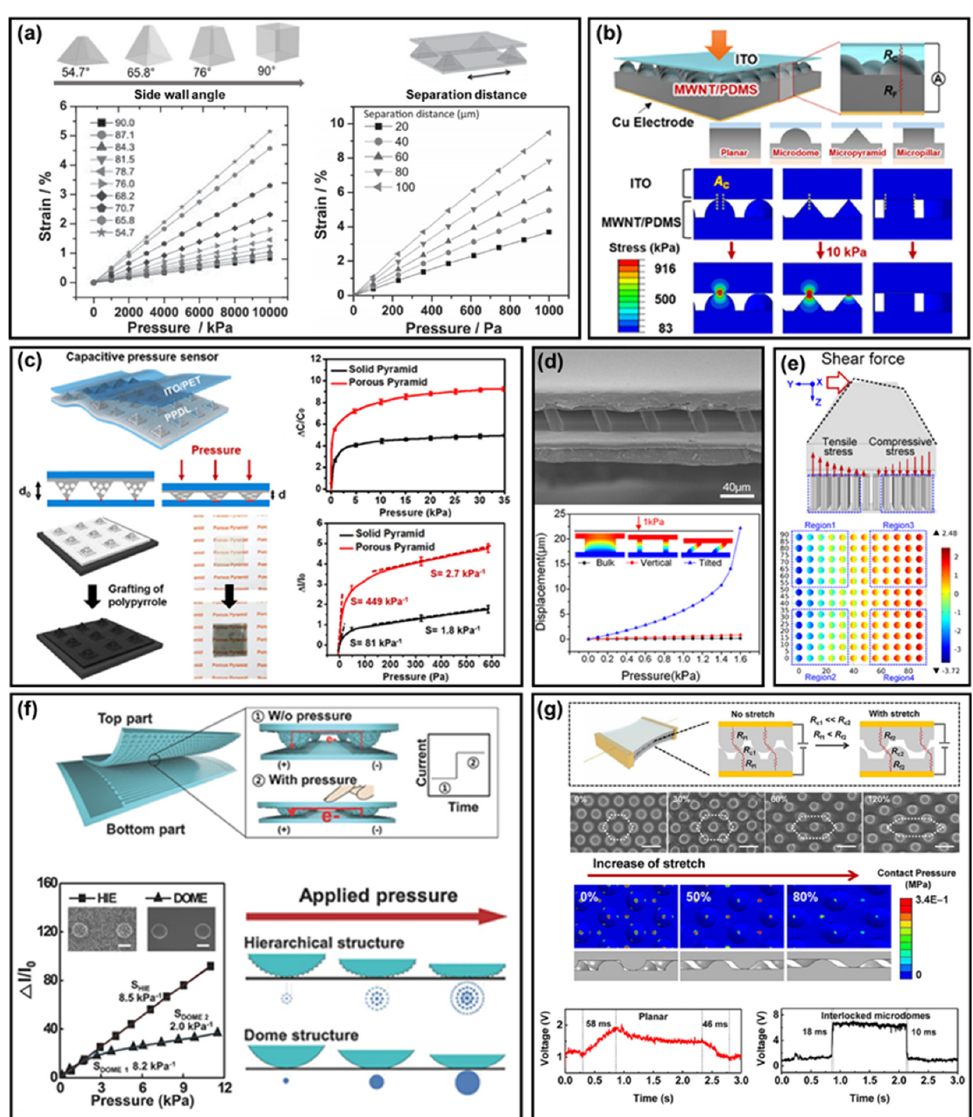
Figure 6. ( a ) Simulation data showing the relationship between shape and strain [216], ( b ) contact area according to nano/microstructure arrays [225]. ( c ) Microarray composed of porous pyramids [227]. ( d ) SEM image of tilted pillar array and finite element method (FEM) simulation [228]. ( e ) Illustration of 3D–axis force sensor and FEM simulation of shear stress [241]. ( f ) Schematic view of sensor operating principle of a hierarchical microstructure array and pressure response [237]. ( g ) Illustration of the interlocking structure sensor operating principle and stretch and sensing response time [211].